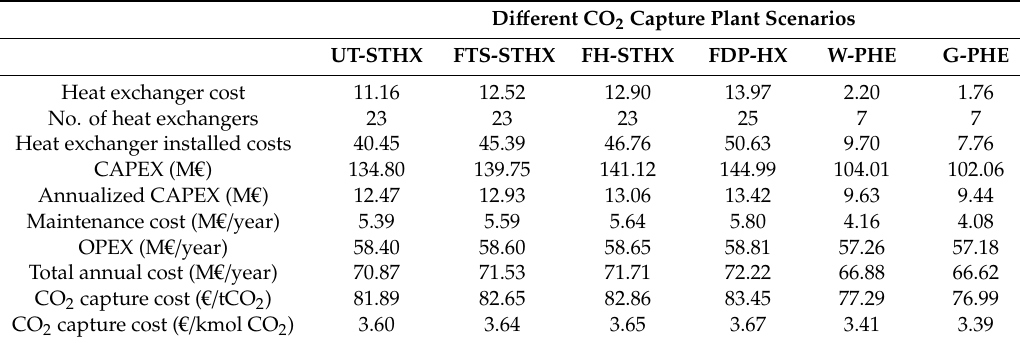
Table 6. Cost performance of all the capture plant scenarios.